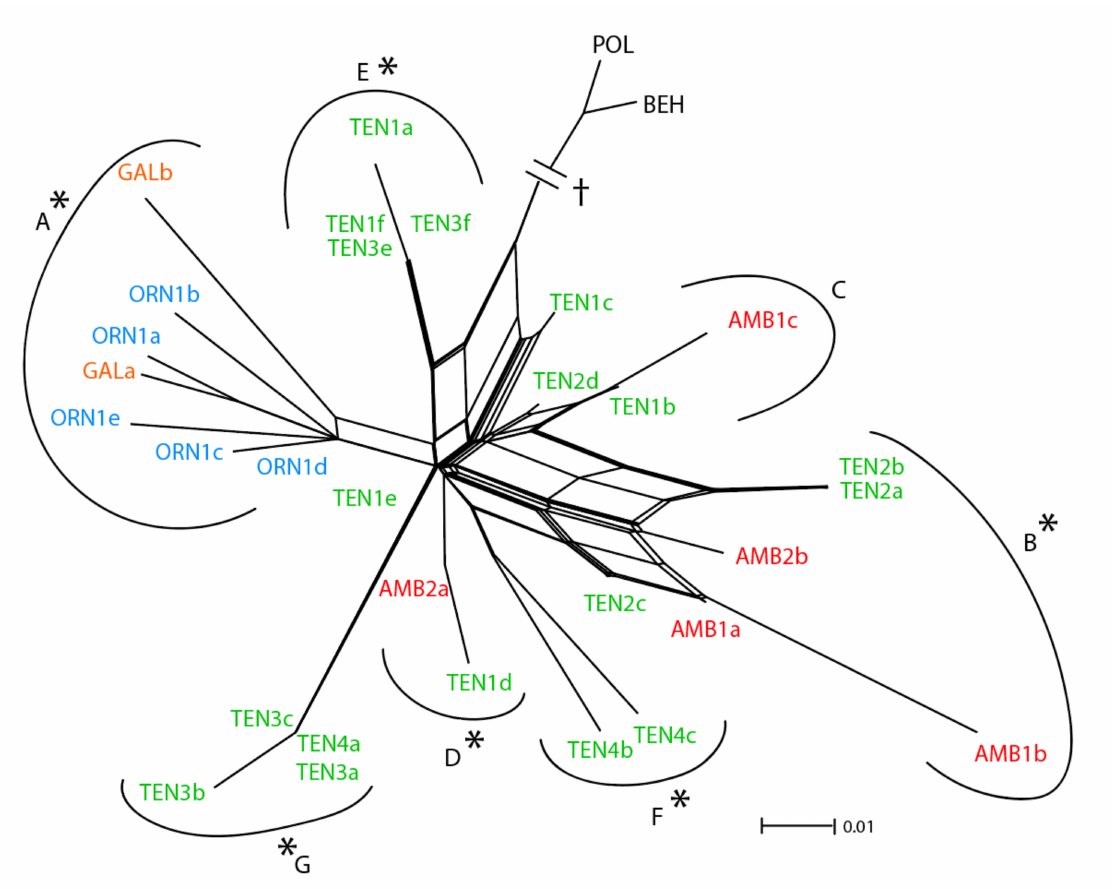
Figure 5. Neighbor-Net for the PgiC region of Centaurea tentudaica. Letters correspond with the clades, shown in Figure S3. * indicates the statistically supported clades in the Bayesian analysis with a posterior probability above 0.90. † =